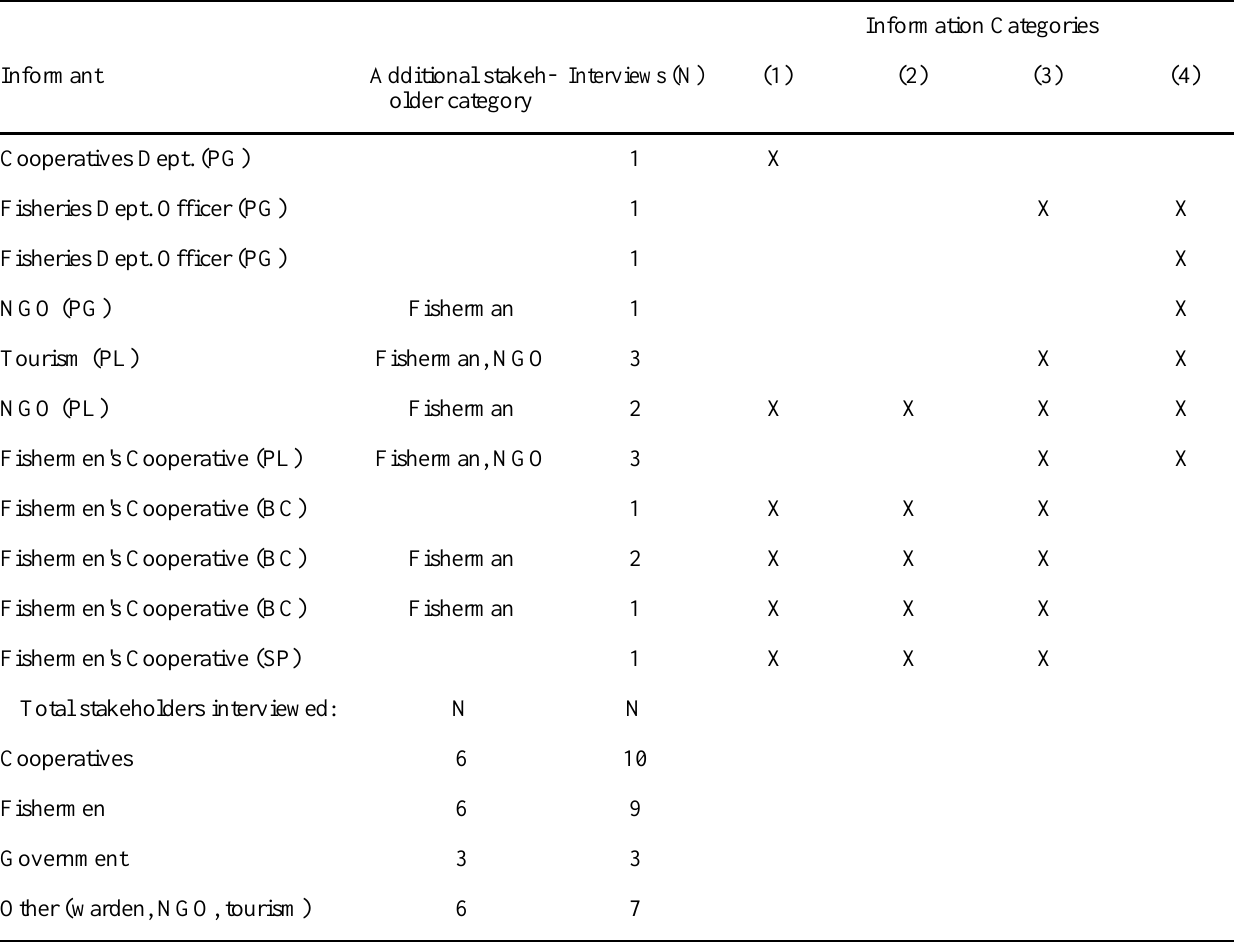
Table 1. Summary of interviews and key informants. The informants have been classified according to their main category as a stakeholder and where they are from or were interviewed (PG – Punta Gorda; PL – Placencia; BC – Belize City; SP – San Pedro). These informants were asked about at least one of